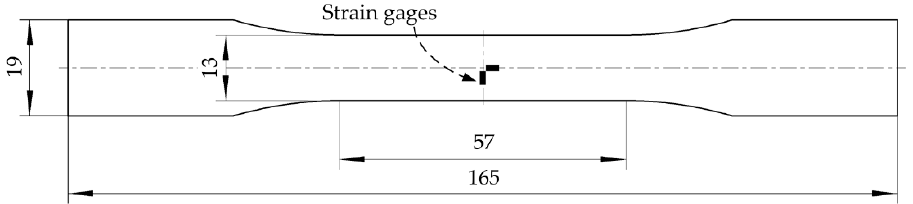
Figure A5. Dimensions of the tensile specimens of the matrix (mm).